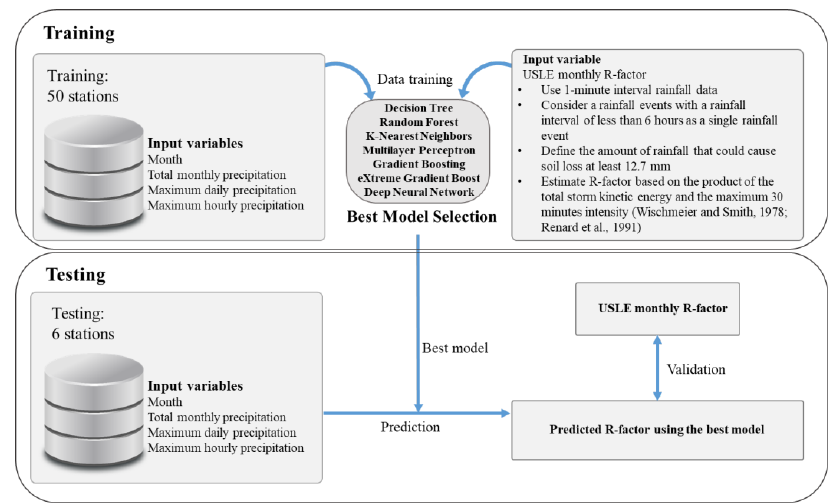
Figure 1. Study procedures.